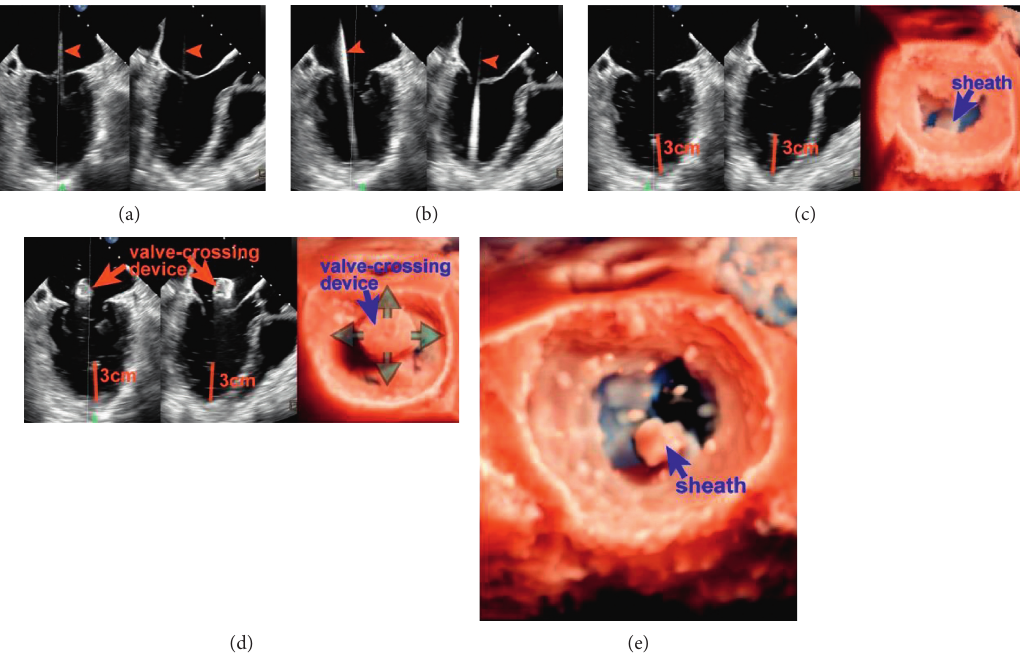
Figure 3: Transapical puncture and introducing the valve-crossing device. (a) X-plane view shows the guidewire enters LA through the mitral orifice (orange arrowhead). After that, a 6F guidewire is exchanged and advanced into LV and LA on a similar view. (b) Arrowhead. (c) 3D enface view +X-plane view show the introducer sheath is inserted coaxially to the LV and the insertion depth is approximately 3cm (orange line). (d) The valve-crossing device is loaded into the introducer sheath and can be shifted in full directions (green arrows) within a reasonable scope of the MV orifice. (e) Coaxial advancement of the introducer sheath into the center of LA along the rod of valve-crossing device. AP: apex.